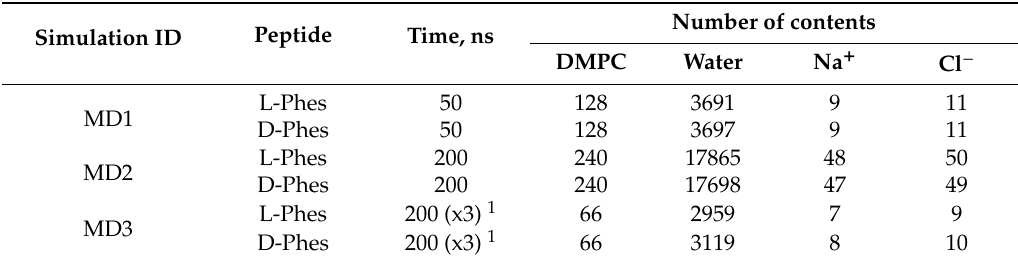
Figure A4. The first and last snapshots in the first simulations systems ( a ); the most populated structures of L- Phes and D-Phes in the first simulations ( b ). Tail groups of DMPC membrane were omitted for the clarity. Table A1. Information of simulation systems.